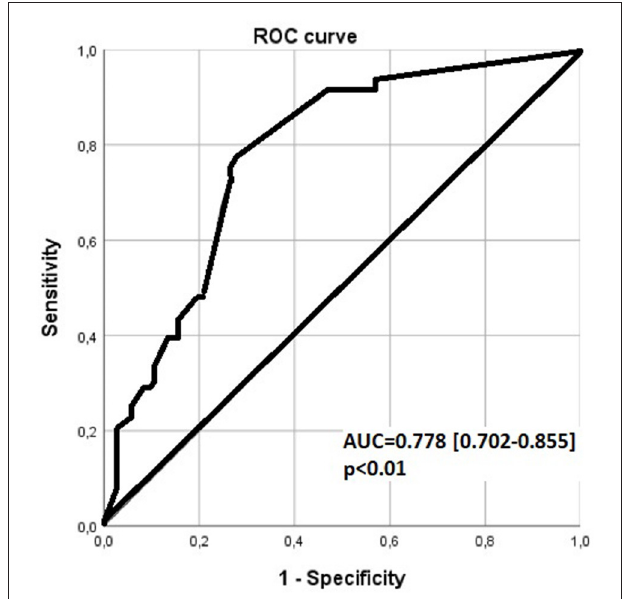
FIGURE 2 | FiO2 level for a second instillation of Surfactant.